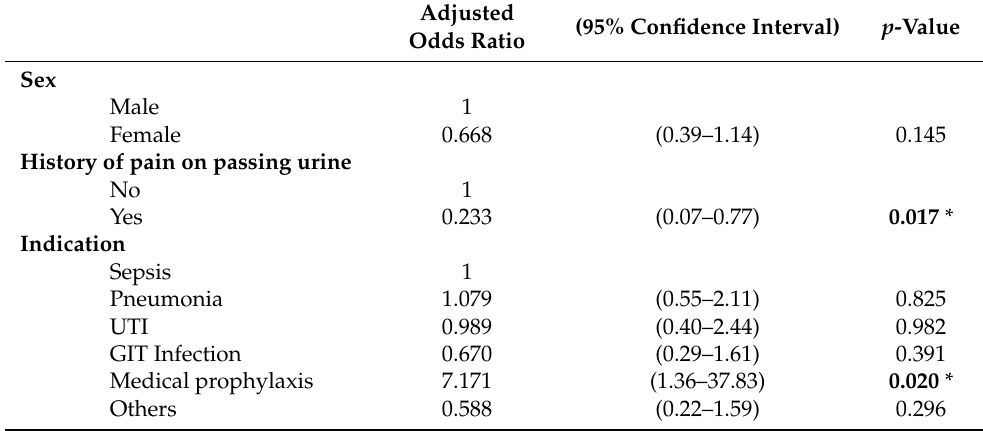
Table 3. Multivariate logistic analysis for factors associated with ceftriaxone